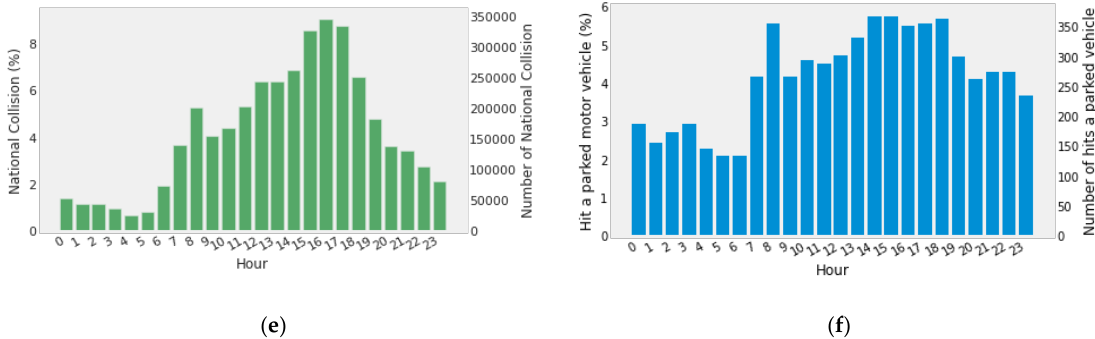
Figure 1. Variation of collision with time in the whole NCDB (1999–2017) dataset [29] ( a , c , e ) and in hit a parked vehicle accident ( b , d , f ).